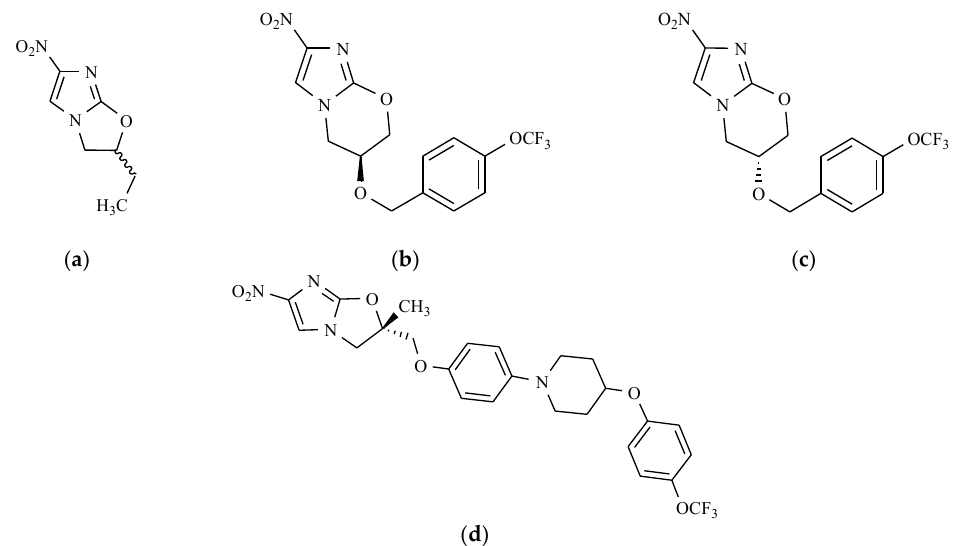
Figure 10. The chemical structure of antitubertulostatic nitroimidazoles: ( a ) CGI-17341; ( b ) (S)-PA-824; ( c ) (R)-PA-824; and ( d ) (S)-OPC-67683.